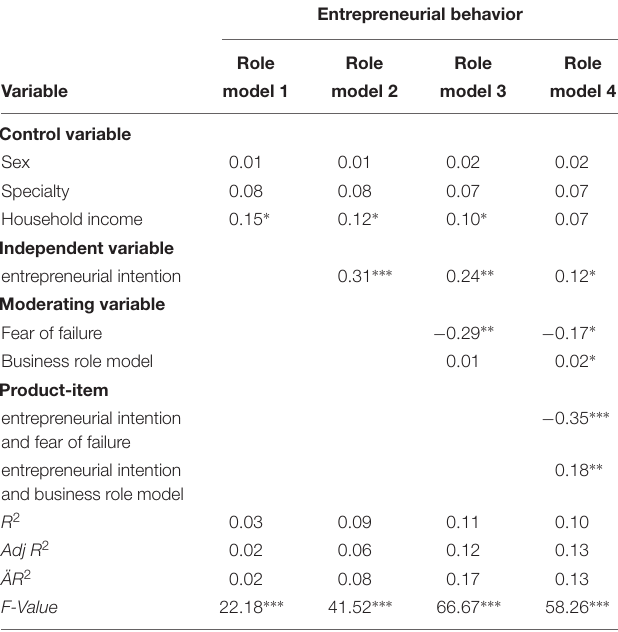
TABLE 3 | Regression role